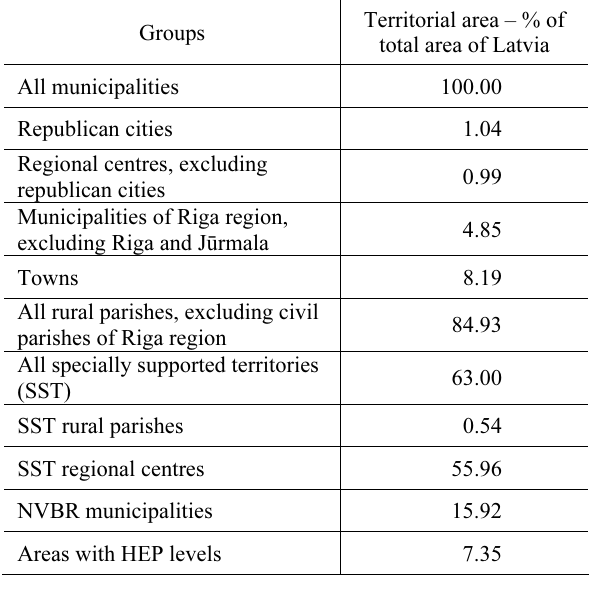
Table 2. Number of residents in studied groups (% of popula-